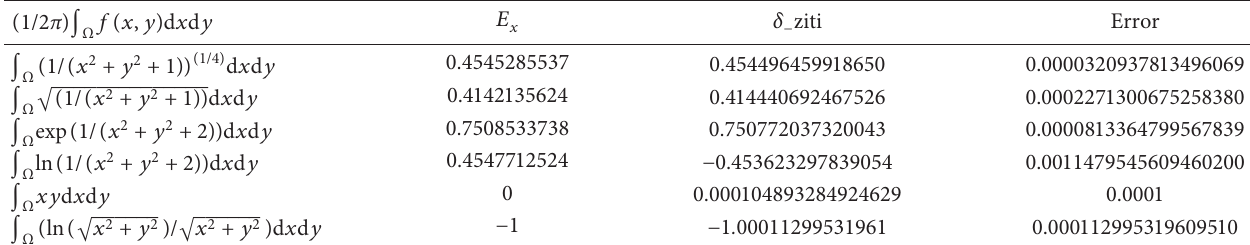
− ziti and the exact value in the polar case.